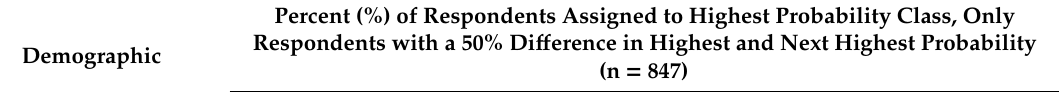
Table 9. Comparison of Latent Class Model class demographics and class assignment